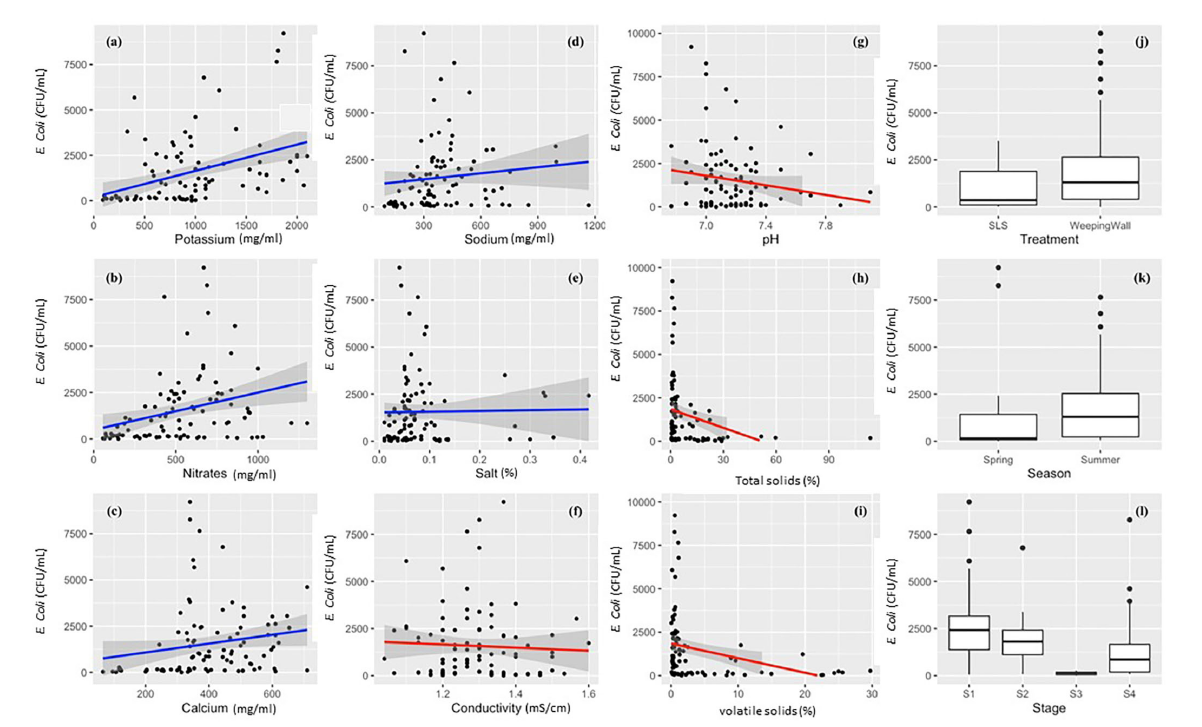
FIGURE3 Descriptive univariate graphs of model variables visualizing the relationship between the individual predictor variables and the outcome variable (live E. coli levels). The continuous variables have been mapped as scatterplots in graphs (a–i) , which include (a) potassium, (b) nitrates, (c) calcium, (d) sodium, (e) total salts/salt, (f) electrical conductivity, (g) pH, (h) total solids/TS, and (i) volatile solids/VS. Each univariate scatterplot has been fit using a smoothened conditional mean in the form of Generalized Linear Models (GLM) with a 95% confidence interval. A blue line indicates a positive relationship (a–e) , red line indicates a negative relationship (f–i) , and the gray shaded area denotes the 95% confidence interval for each GLM that has been fit to the data points in the graph.